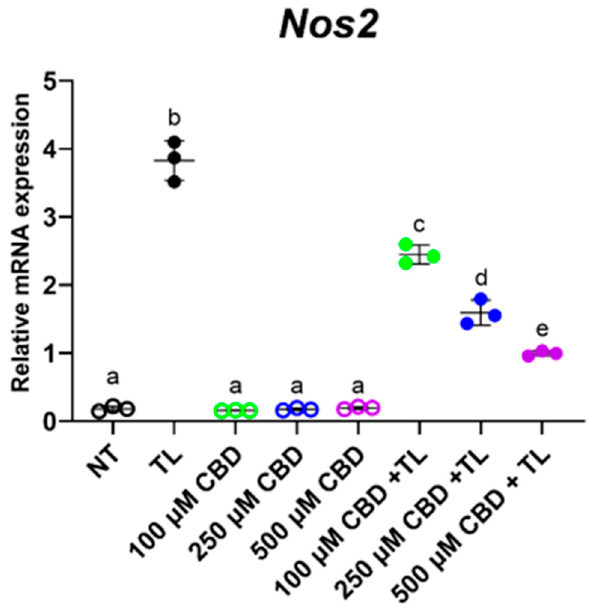
Figure 3. CBD decreased expression of inflammatory markers in intestinal organoids. Mature ileal organoids were treated with Tnf α + LPS (TL) to induce inflammation or treated with increasing concentrations of CBD in the absence or presence of TL. Negative controls consisted of no treatment (NT). On day 4, after organoids were passaged, organoids were incubated with treatments ( n = 6 wells per treatment) for 24 h; each well contained approximately 100 mature organoids. Organoids were harvested and RNA was extracted for qPCR and the relative expression of target genes were determined using the 2e- Δ ct method. Outliers were not detected after ROUT test. Significant differ- determined using the 2e- ∆ ct method. Outliers were not detected after ROUT test. ences between treatments were detected using one-way ANOVA followed by a Tukey post hoc test. Different letters indicated significant difference between treatments.